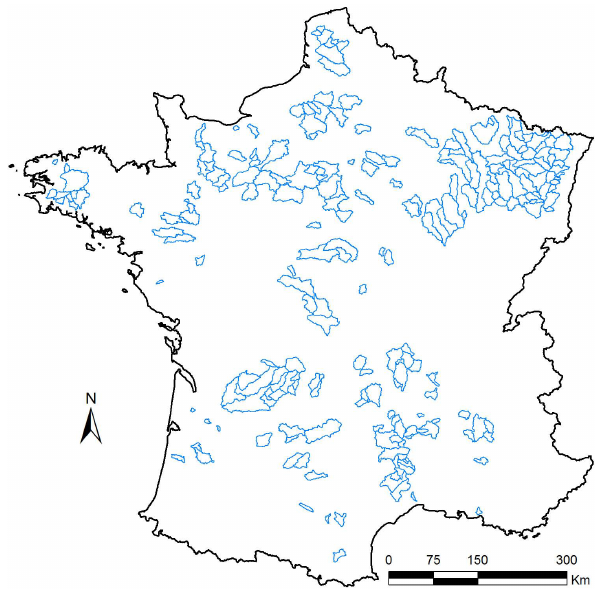
Fig. 1. Location and boundaries of the 237 French catchments used in this study (after Le Moine,